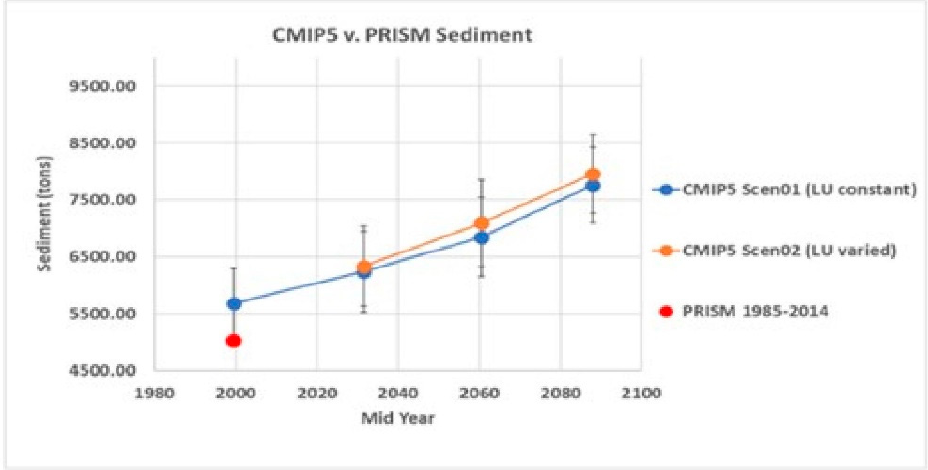
Figure 5. PRISM vs. average of 20 CMIP5 GCMs sediment (2018–2100).